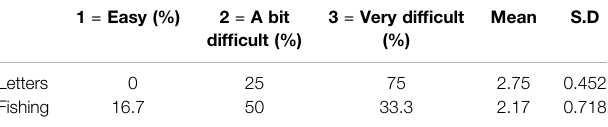
TABLE 5 | Descriptive analysis of the Letters and Fishing